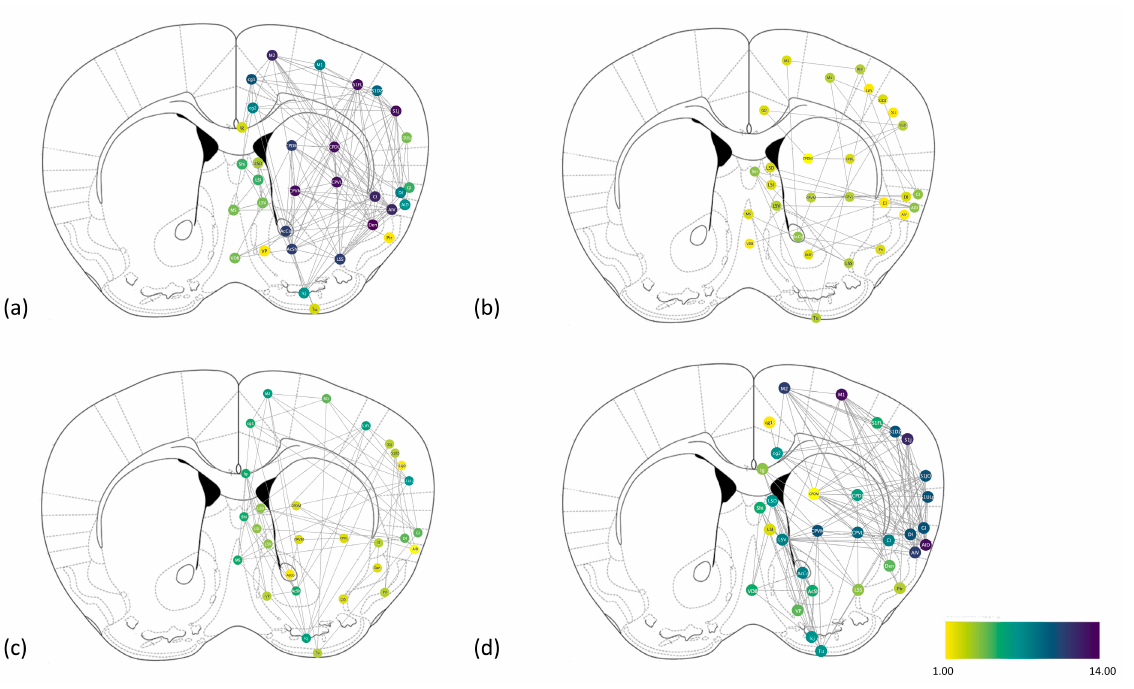
Figure 4. Graph representation of the brain networks for VEH/VEH ( a ), VEH/ASE ( b ), KET/VEH ( c ), and KET/ASE ( d ) groups. Nodes represent ROIs and the color reflects the corresponding degree.